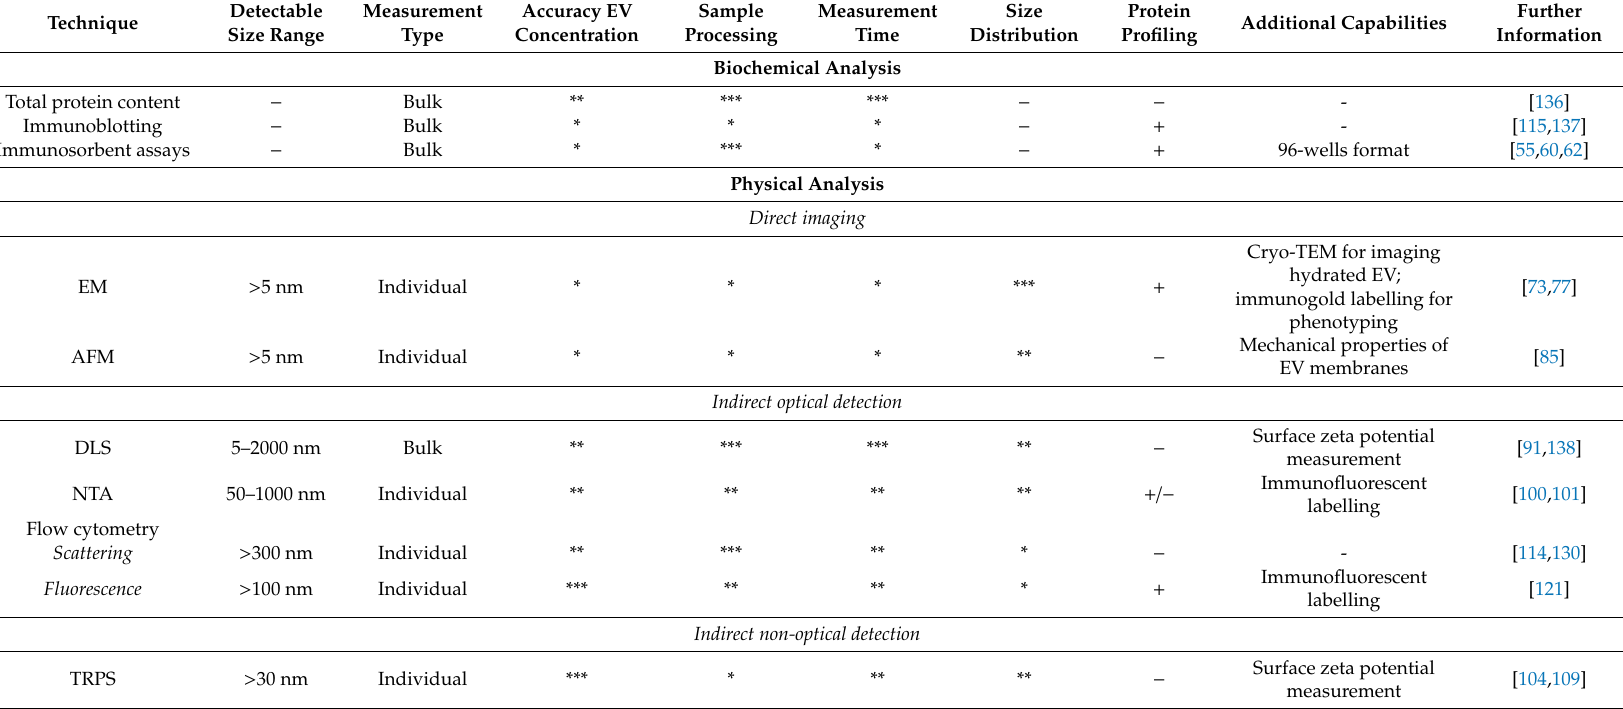
Table 1. Summary of the capabilities of the most common methods for EV analysis. Methods are grouped according to their type (biochemical or physical analysis), with subgroups based on the principle of EV detection. Evaluation of performance of each technique is given by the number of stars, with * being the poorest performance and *** being best performance out of the compared